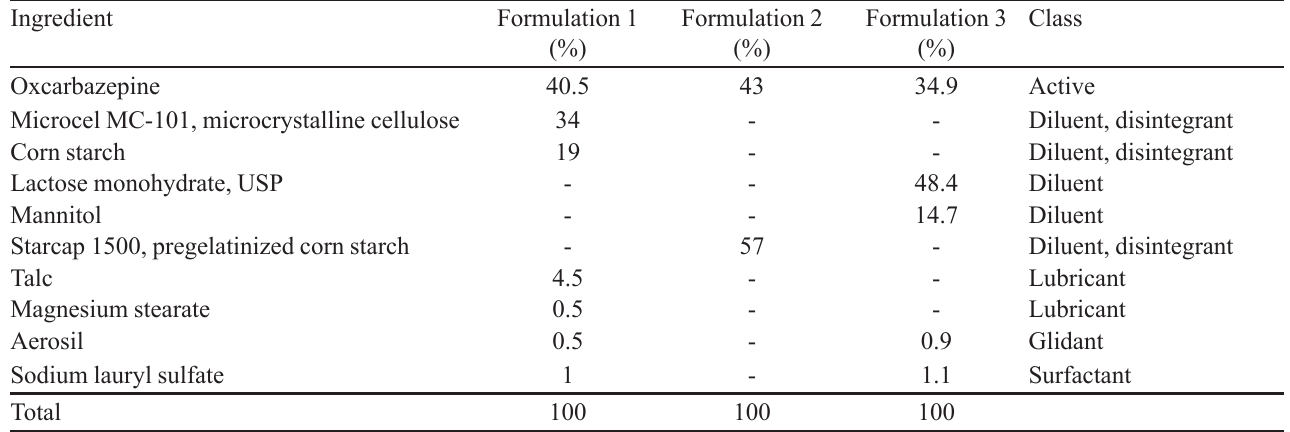
TABLE I - Formulations of 150 mg OXC Capsules